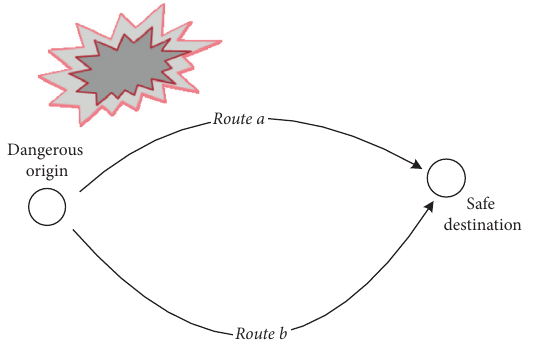
Figure 1: A schematic description of the route choice